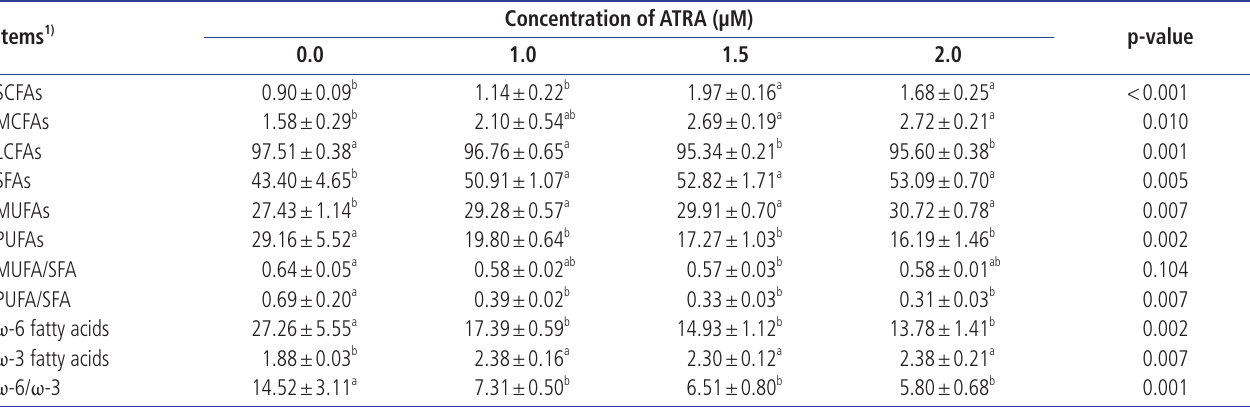
Table 3. Comprehensive analysis of fatty acid composition of MAC-T cells treated with ATRA Items 1)